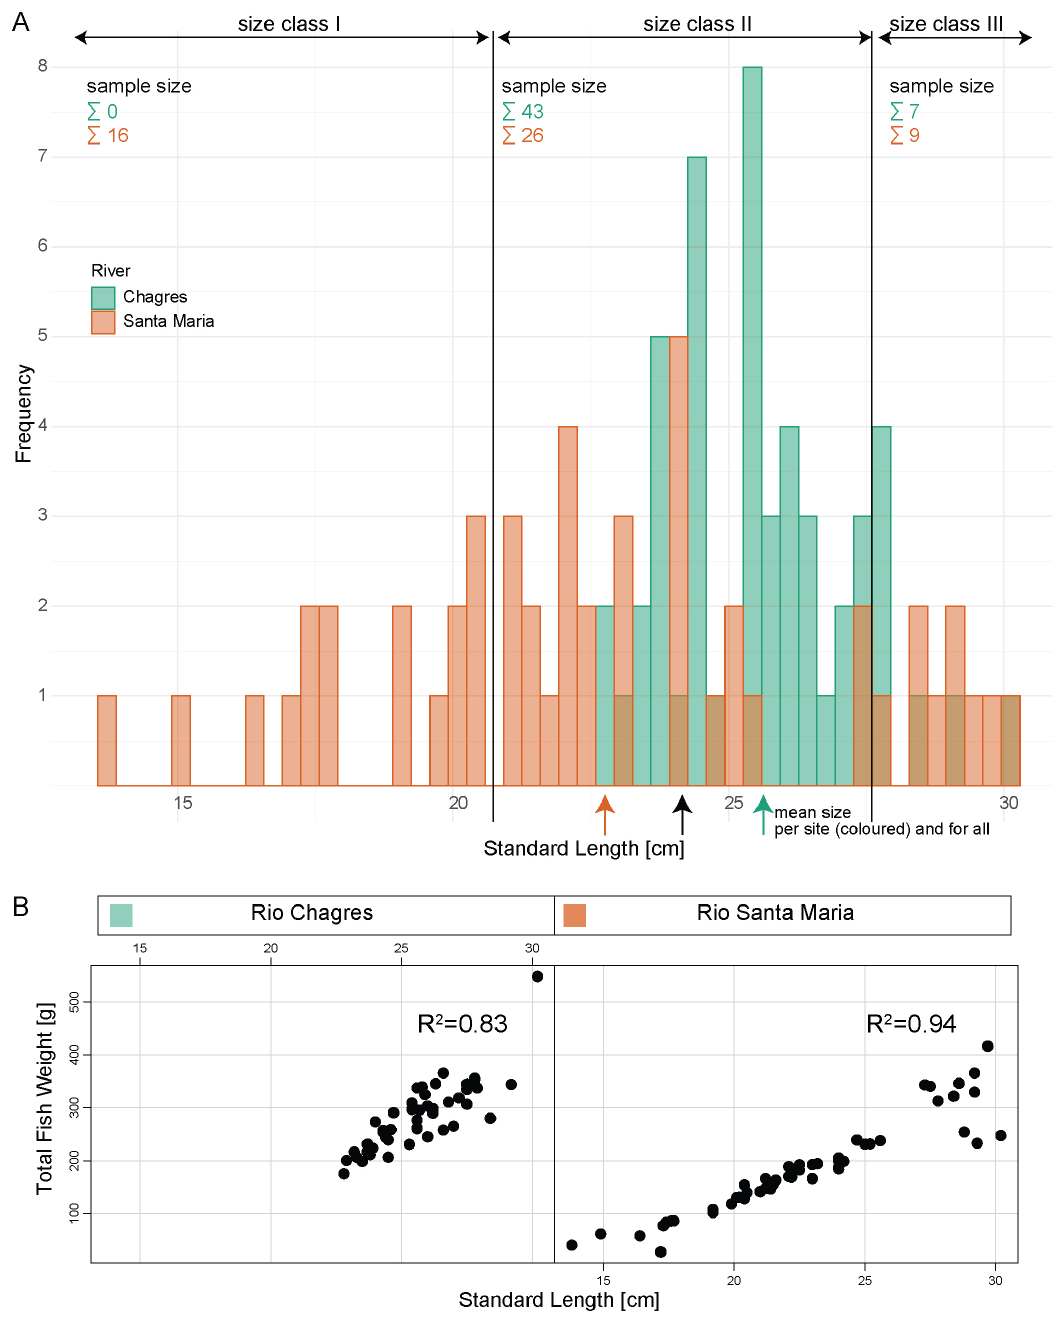
FIGURE 2 | Size distribution of Cathorops tuyra (February 2019) from Rio Santa Maria and Rio Chagres, Panama. A. Size histogram and size bins. Rio Chagres (freshwater population) in green, Rio Santa Maria (estuarine population) in orange. Size classes were defined by determining the mean standard length for all individuals (indicated by black arrow) and then going one standard deviation below and above to make the cut offs (indicated by the solid black lines) such that size class one was individuals up to one standard deviation below the average while size class three was made up of individuals above one standard deviation above average and size class two was all the individuals between those two standard deviations. The colored arrows indicate the mean standard lengths of each river. B. Weight-size relationship of 50 Rio Chagres and 51 Rio Santa Maria